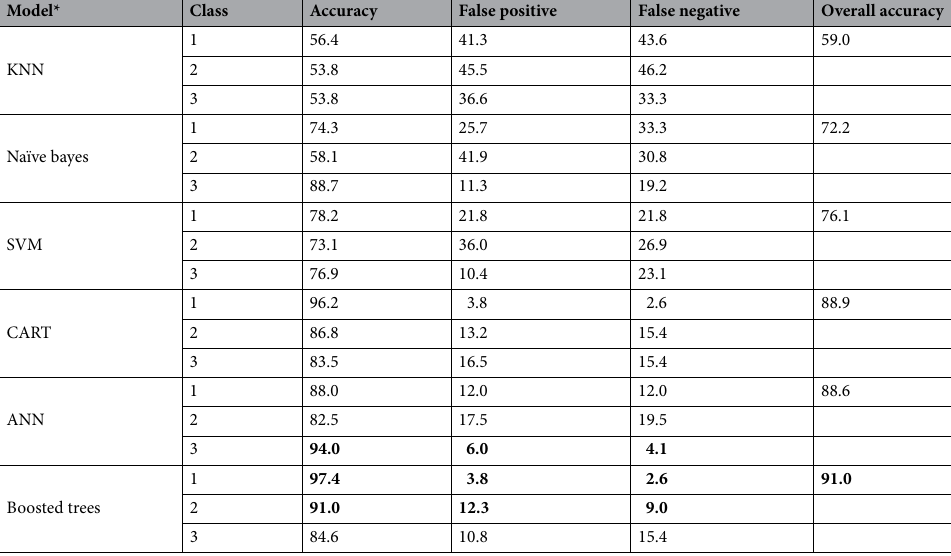
Table 2. Validation performance of utilized machine learning models. All models’ performance metrics are evaluated based on a five-fold cross validation study. *The exact computational time depends on the configuration of the parallel computing environment. In this case, local parallelization is used, 4 cores sharing 24 GB. The average computation cost to train the complete CIC framework and assess a failure event from a given incident report is ~ 8 min. This is based on the optimal CIC configuration and using the aforementioned computational settings. Best performance values are in [ bold ].